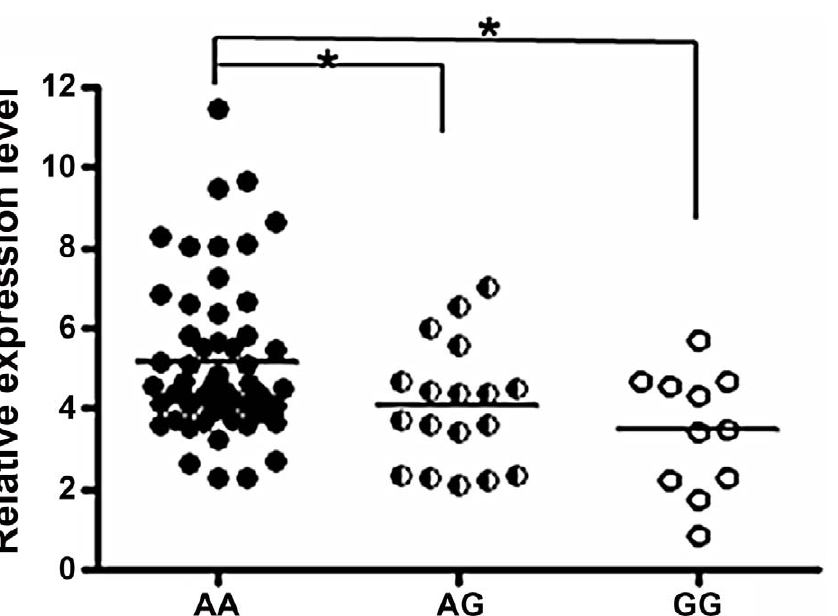
Figure 1. Comparison of miR-146a expression levels between groups of healthy individuals with different rs57095329 genotypes. The horizontal line indicates the mean expression level within each group. * indicates P , 0.05.